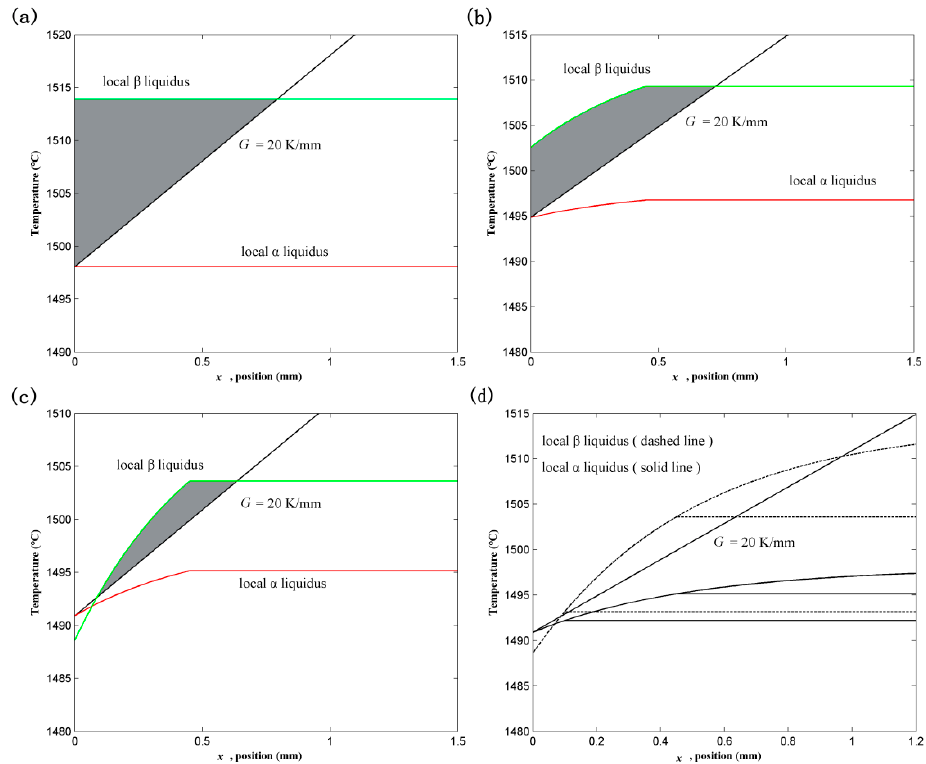
Figure 4. Local temperature and local liquidus temperatures of α and β and the constitutional undercooling with respect to β (grey region) during the general seeding process when the growth distance is 0 mm ( a ), 5 mm ( b ) and 50 mm ( c ) and the effect of the δ on the constitutional undercooling when the steady state is reached ( d ).